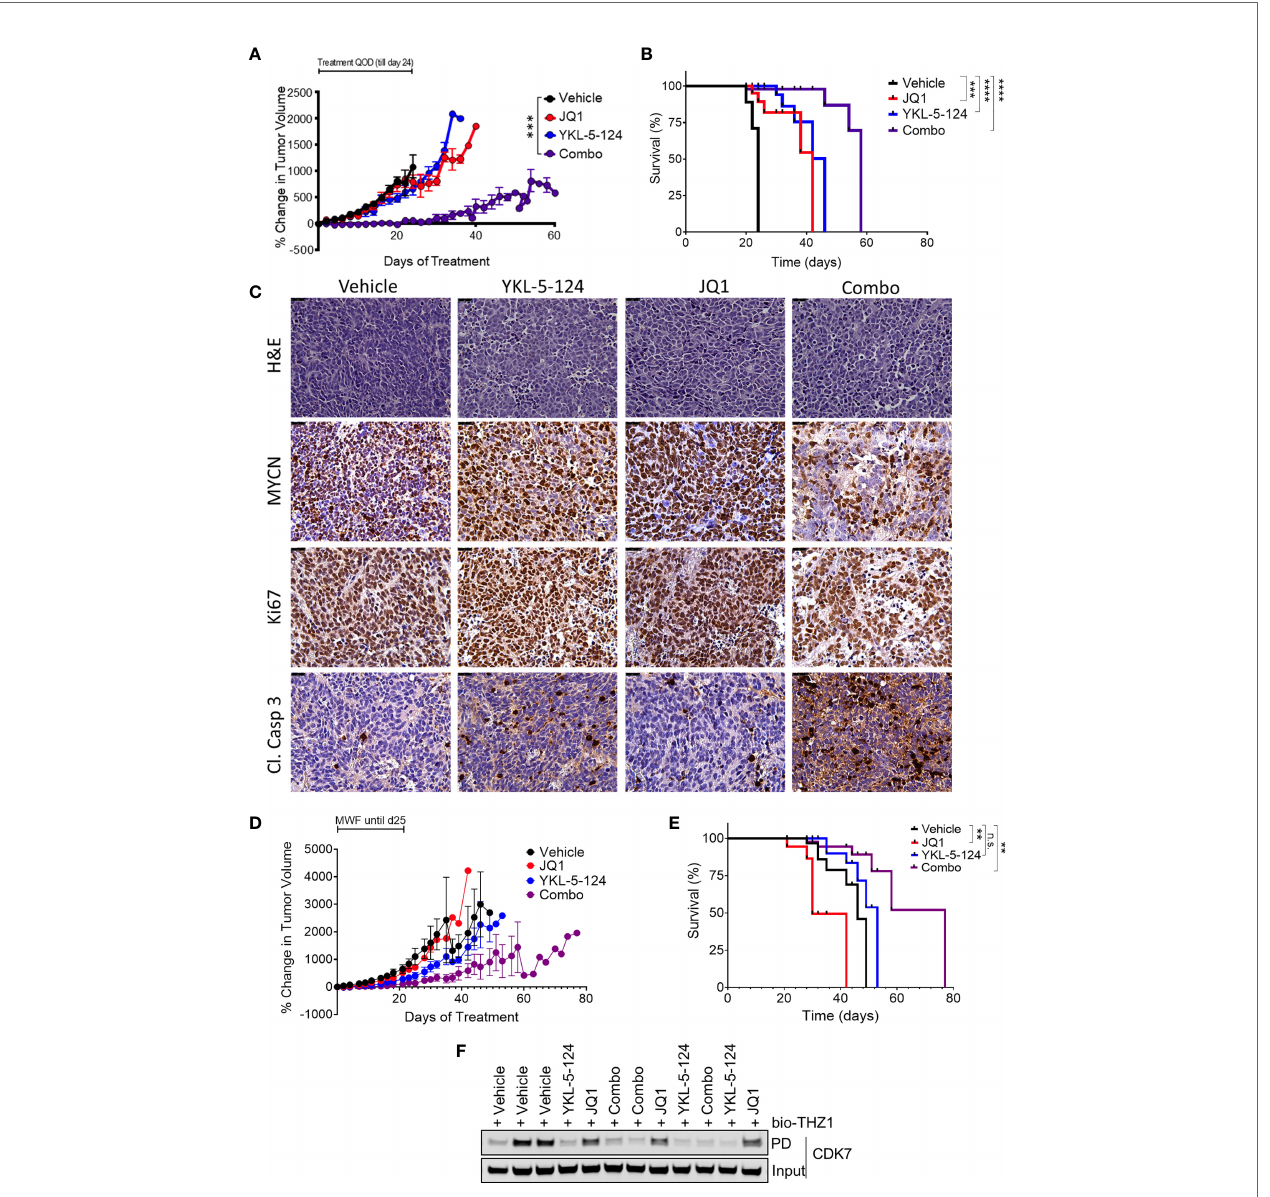
FIGURE 5 | The combination of YKL-5-124 and JQ1 leads to improved therapeutic ef fi cacy in vivo . (A) Tumor volumes of IMR-32 NB xenografts in NSG mice treated with 2.5 mg/kg YKL-5-124, 25 mg/kg JQ1, JQ1 and YKL-5-124 or vehicle control (5DW +10% DMSO + 10% HP-beta-cyclodextrin) QOD including weekends for 24 days. Mean ± SEM values are presented. (n=5, all arms) *** P < 0.001, as compared to vehicle. (B) Kaplan-Meier survival curves for the experiment described in (A) but with mice with BCS<2 excluded. *** P < 0.001, **** P < 0.0001 (log-rank test). (C) Immunohistochemical (IHC) analysis of morphology (hematoxylin & eosin, H&E), proliferation (Ki67), apoptosis (cleaved caspase 3) and MYCN in tumors harvested from animals treated as described in (A) for 7 days. Magni fi cation, 40X. (D) Tumor volumes of PDX tumors in NSG mice treated with the indicated agents at similar doses as in (A) or vehicle control three times per week for 28 days (14 total treatments). Mean ± SEM values are presented. (vehicle n=8, other arms n=6). (E) Kaplan-Meier survival curves for the experiment described in (C) ** P < 0.01, ns, not signi fi cant (log-rank test). (F) Analysis of target engagement in tumors from mice treated as described in (C) Lysates prepared from homogenized tumor tissue were incubated with bio-THZ1 for 24 h at 4°C and immunoprecipitated proteins analyzed for CDK7 by